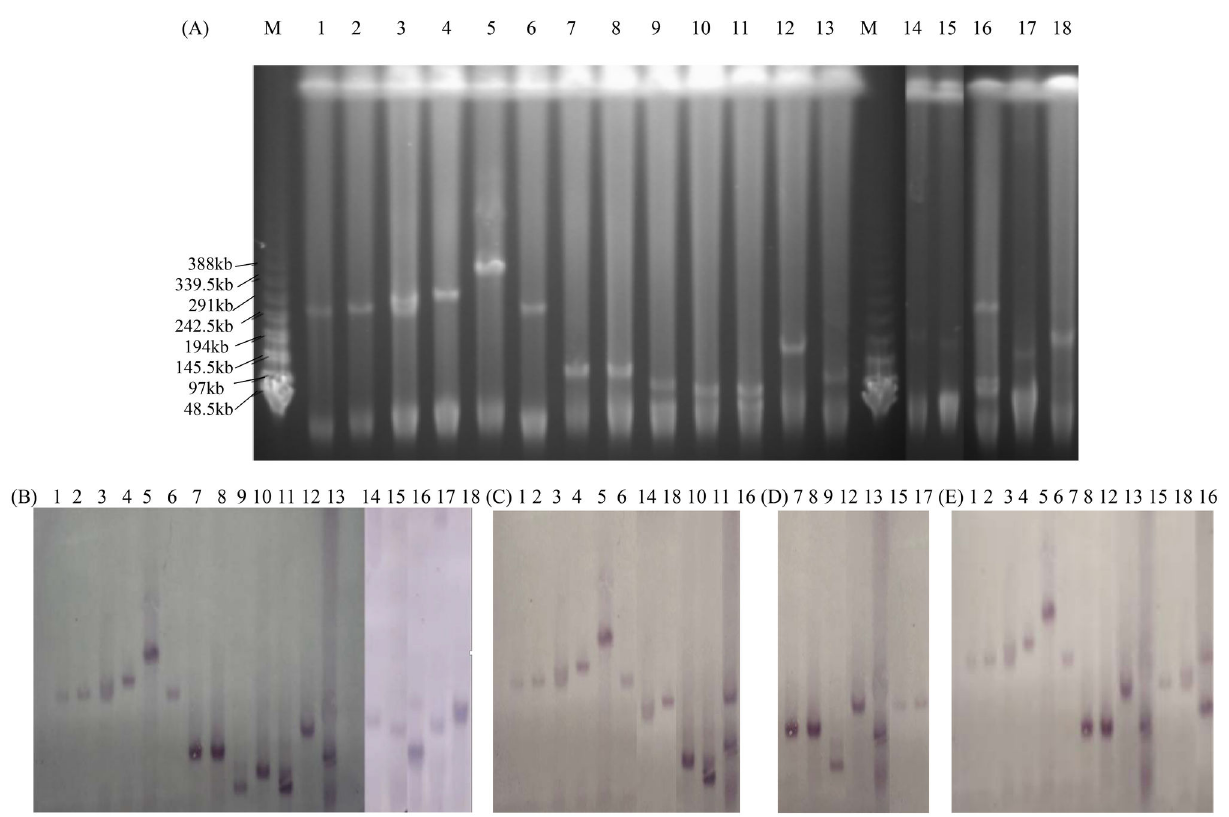
Figure 1. Plasmid analysis of transconjugants carrying oqxAB and bla . (A) S1 nuclease-PFGE (B) Southern blot CTX-M hybridization with the oqxAB probe. Lane 1-18: 45-6T, FS1Z4ST, a78T, CBJ3CT, a64T, 2YG4T, FS5E1DT, 42-2-2T, FS9Y1CT, A6T, 70zuT, FS3Z3GT, FS2Y1XT, FS6J2CT, 33-2T, 5weiT, FS3Z3CT, 7ganT; Lane M: lambda ladder PFG Marker. (C) Southern blot hybridization with the bla probe (D) Southern blot hybridization with the bla probe (E) Southern blot hybridization CTX-M-9G CTX-M-1G with the floR